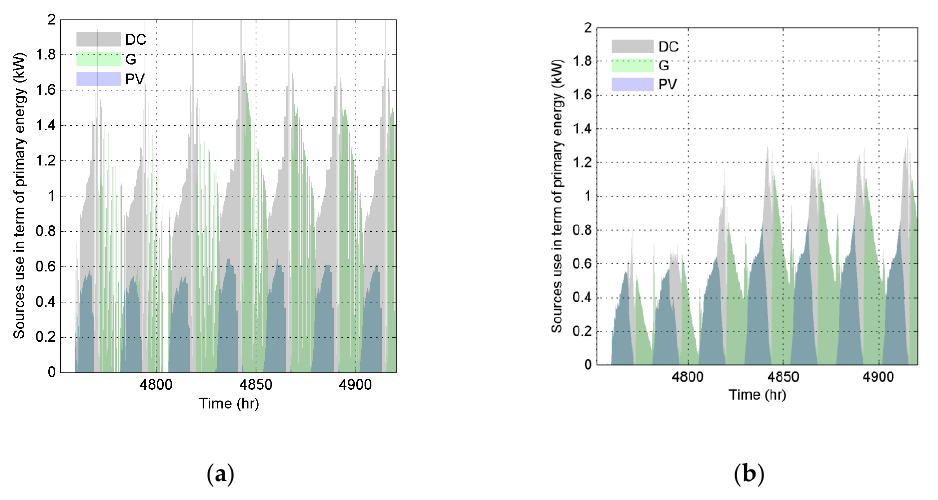
Figure 18. Primary energy use per source: ( a ) RBC; ( b ) MPC (OF P , PH of 18 h).